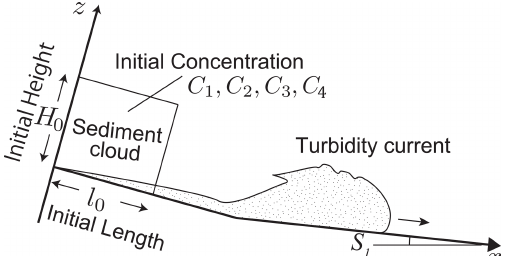
Figure 3. Model input parameters. The initial conditions of the tur- bidity current are assumed to be the suspended sediment cloud that is H 0 and l 0 in height and length, respectively. The initial sediment concentrations C 1 to C 4 and the basin slope S l are to be specified for calculation. These seven input parameters are subject reconstruction by inverse